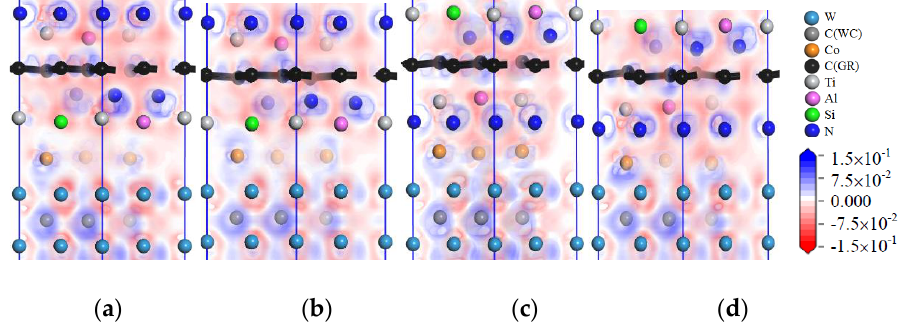
Figure 11. Charge-density difference image of the interface models with intrinsic graphene doping in the coating: ( a ) TiAlSiN/msGR/TiAlSiN Si /WC-Co; ( b ) TiAlSiN/acGR/TiAlSiN Si /WC-Co; ( c ) TiAlSiN/zzGR/TiAlSiN Si /WC-Co; ( d ) TiAlSiN/msGR/TiAlSiN N /WC-Co; ( e ) TiAlSiN/acGR/TiAlSiN N /WC-Co; ( f ) TiAlSiN/zzGR/TiAlSiN N /WC-Co.